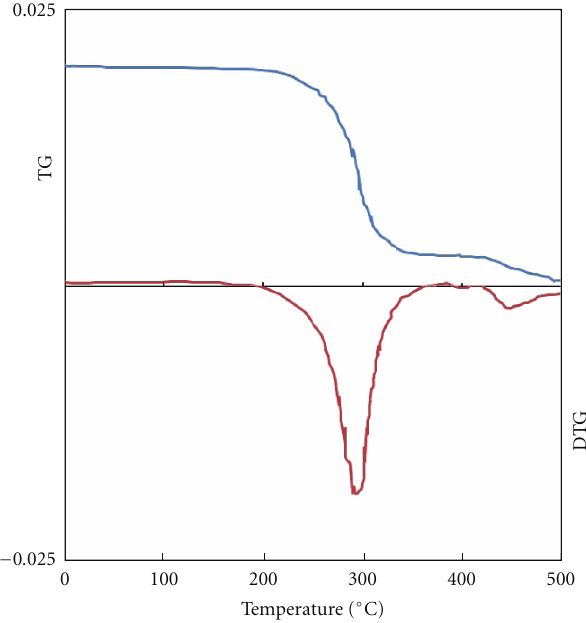
Figure 6: TG/DTG thermogram of sample nC 5 .